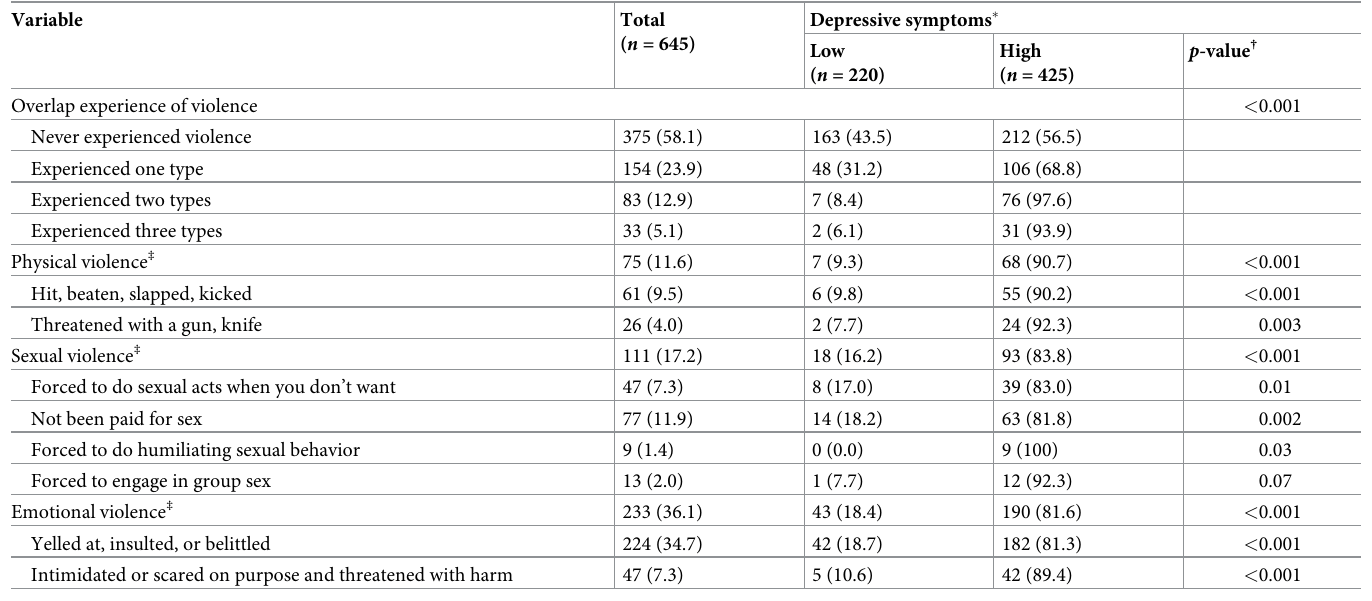
Table 3. Comparison of past year experience of GBV among FEWs with low and high levels of depressive symptoms (n =